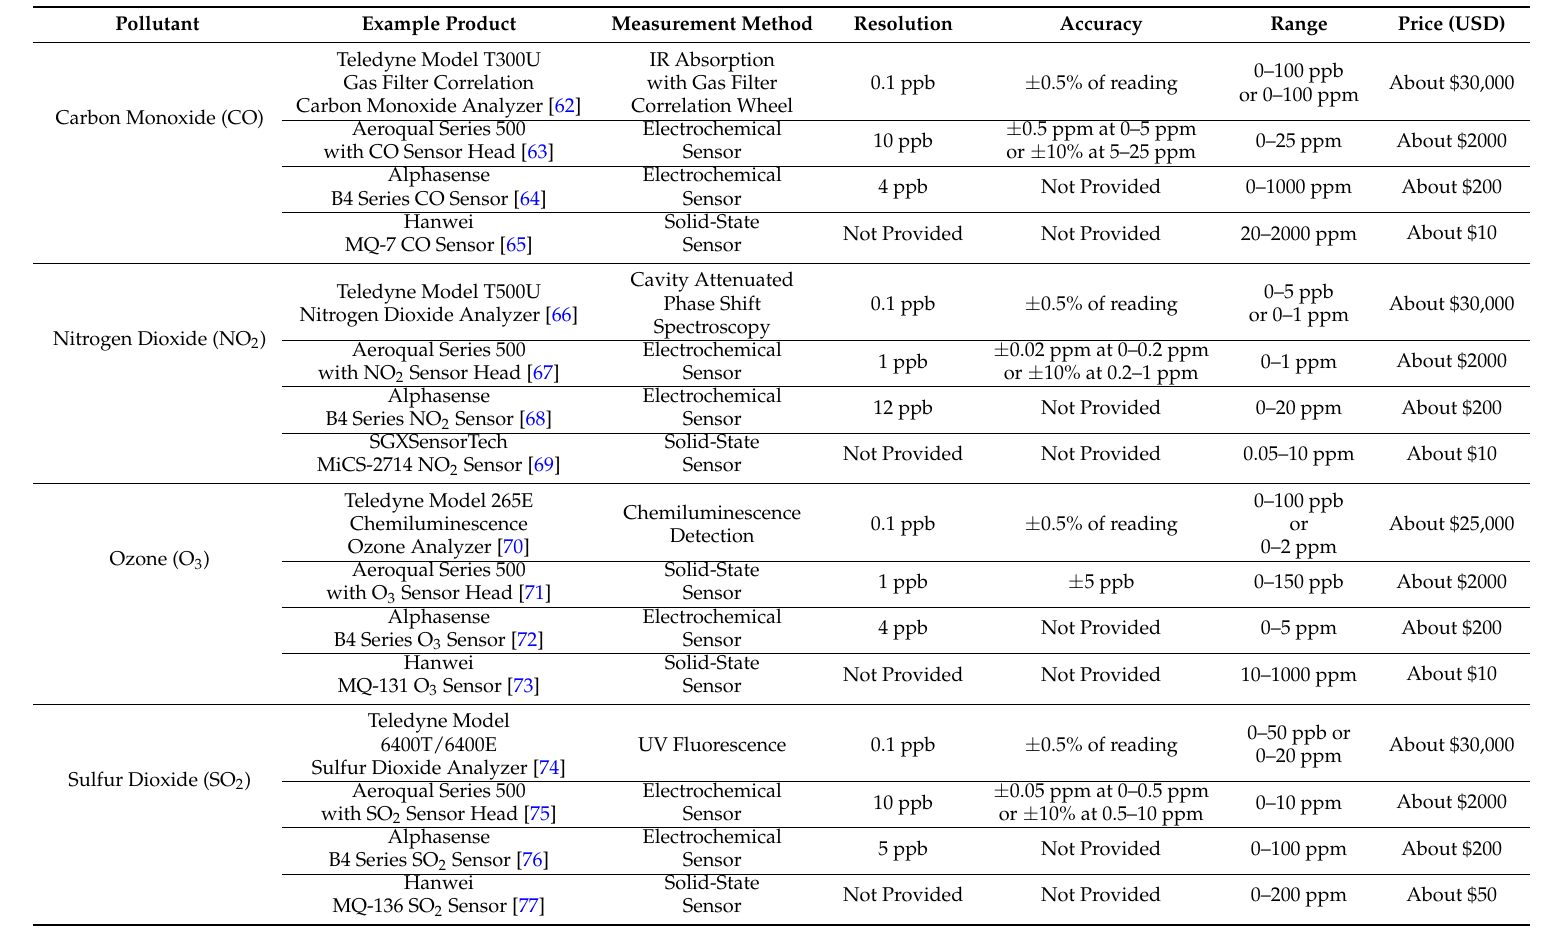
Table 6. Instruments used in air quality monitoring systems (Part